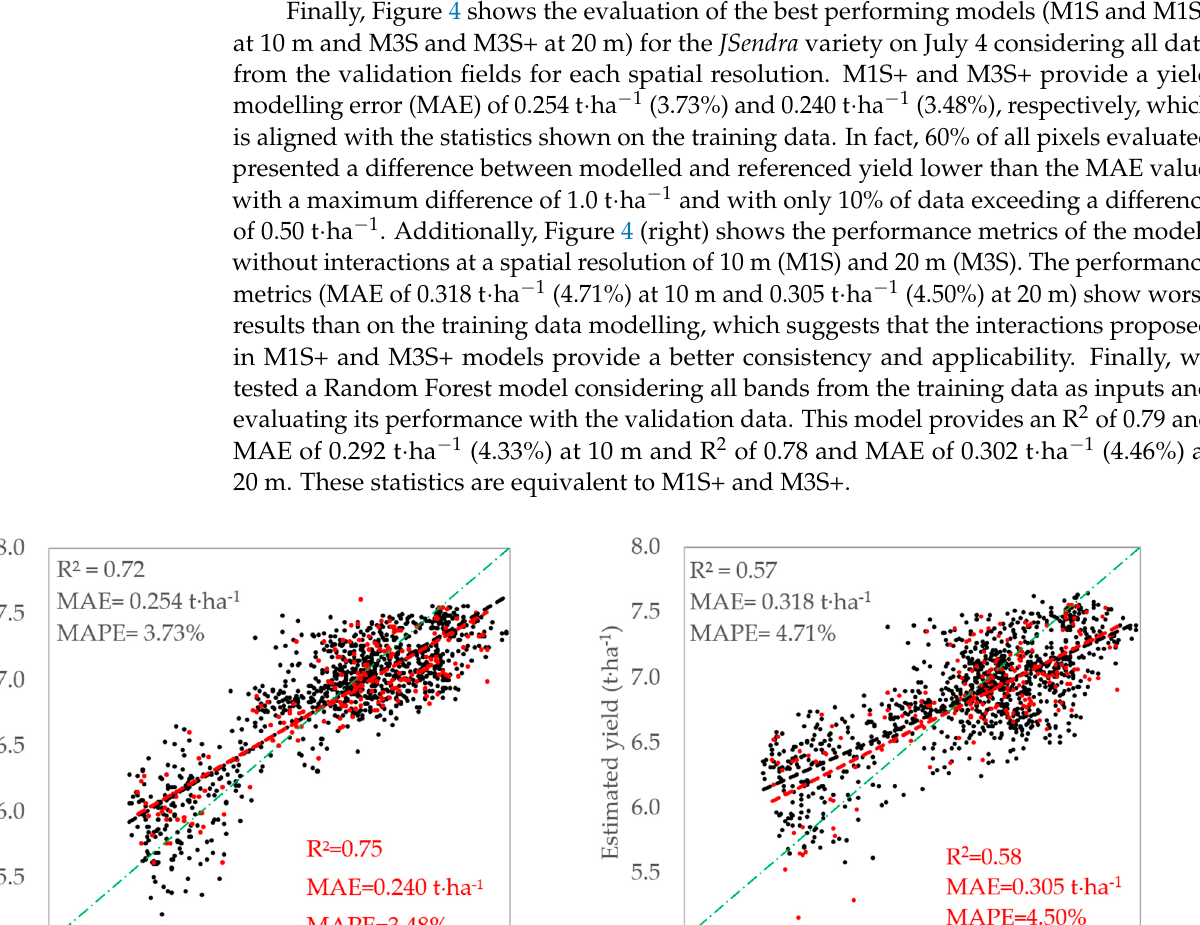
Table 4. JSendra best model evaluation for each date and spatial resolution with training data.